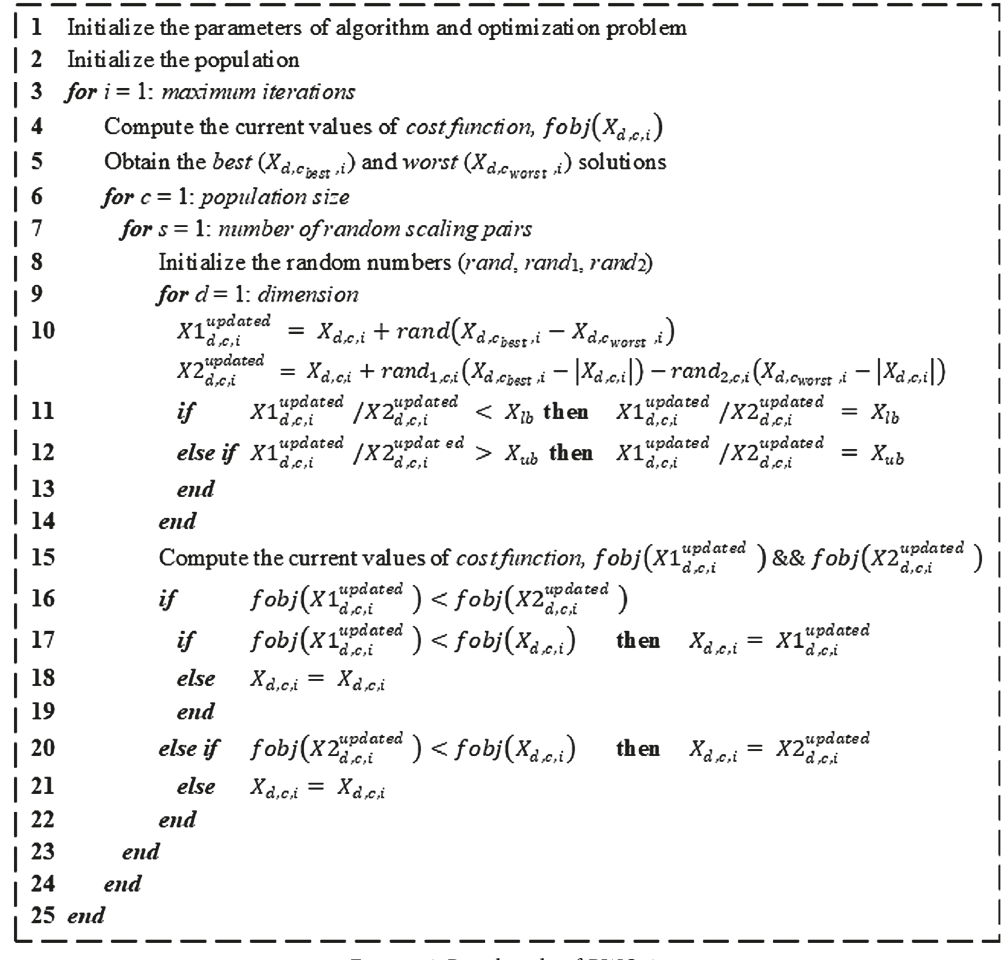
Figure 6: Pseudocode of